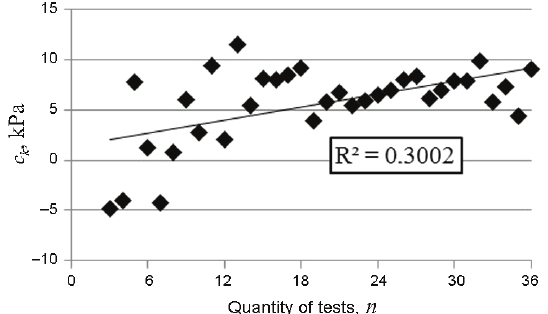
Fig. 9. Cohesion versus the quantity of tests